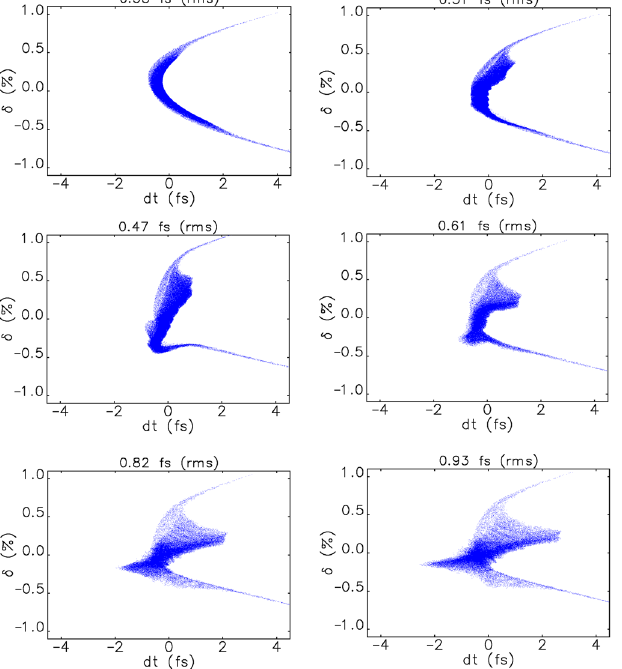
FIG. 5. Final longitudinal phase space simulated by IMPACT - T without self-force (upper left), with only space-charge effects (upper right) and with both space-charge and CSR effects (middle left), as well as simulated by CSRT rack (middle right), with σ ¼ σ = 5 (lower left) and with σ v; sub v The bunch charge is 2.7